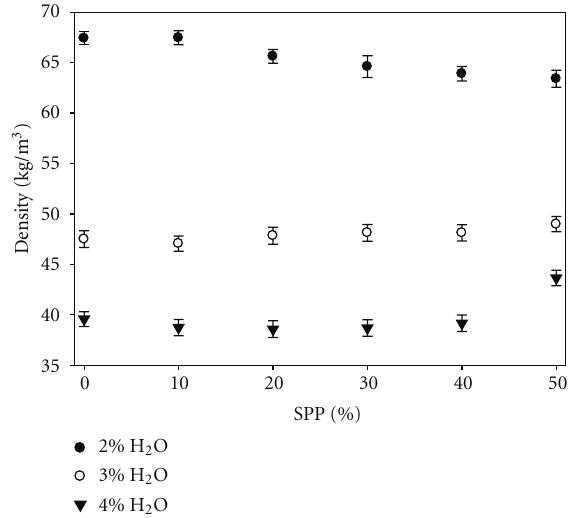
Figure 2: E ff ect of SPP percentage on density of rigid PU foams with di ff erent water contents.